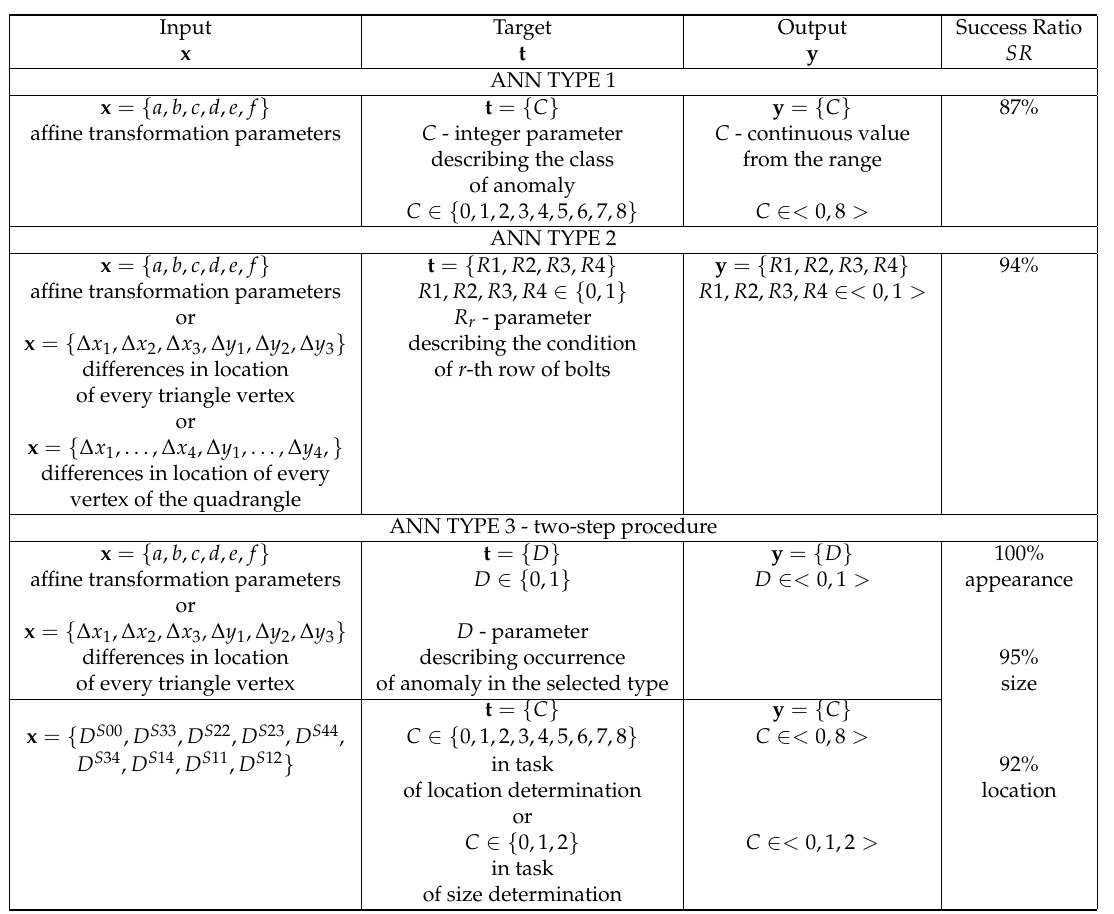
Table 1. Input ( x ) and output ( y ) vectors, as well as targets ( t ) and the value of the best success ratio (SR) obtained for Artificial Neural Networks (ANNs) considering their